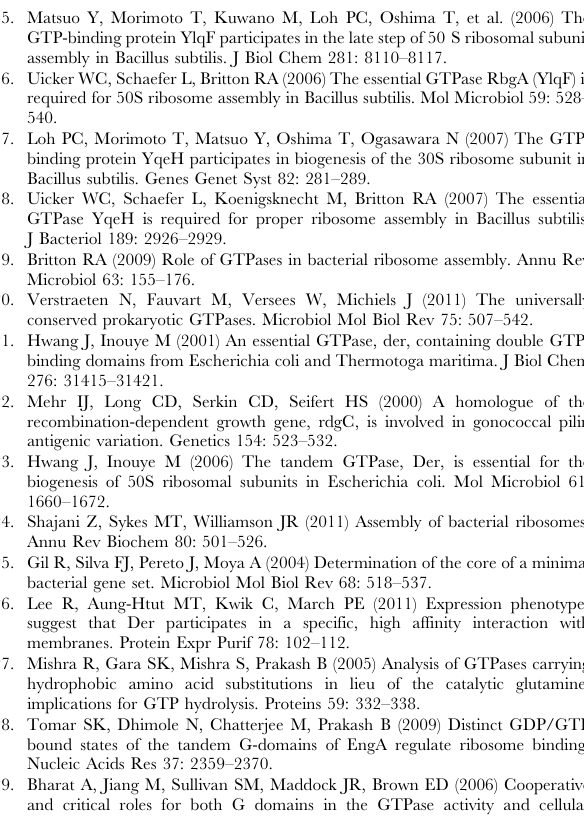
Figure S6 Superimposition of GD1 or GD2 nucleotide- binding site from different EngA structures. A , GD1 domains. The EngA1 is depicted in pale yellow, with the sulphate ion shown in yellow (sulfur atom). The EngA3 structure is depicted in orange with the GDP bound molecule shown in cyan. The EngA4 structure is depicted in green and T. maritima EngA is depicted in purple, including its two bound phosphate ions in pink (phosphorus atoms). B, G2 domains. The EngA4 GD2 is depicted in pale yellow with its bound GMPPCP molecule shown in turquoise. The EngA3 GD2 is depicted in grey, with its bound GDP molecule in cyan. Figure S7 View of the EngA GD2 switch II region and its superposition with MnmE, FeoB and Ras-RasGAP. The EngA GD2 is shown in yellow with the switch II region highlighted in orange with its own GDP and GMPPCP, super- imposed here, depicted in cyan. The FeoB K + and Mg 2 + ions are shown as semitransparent pale green and purple spheres, respectively. K-loops are shown in light blue (FeoB) and pink (MnmE) coils. Ras Gln61 and RasGAP Arg789 (arginine finger) are shown in turquoise. Hydrogen bonds stabilizing either the